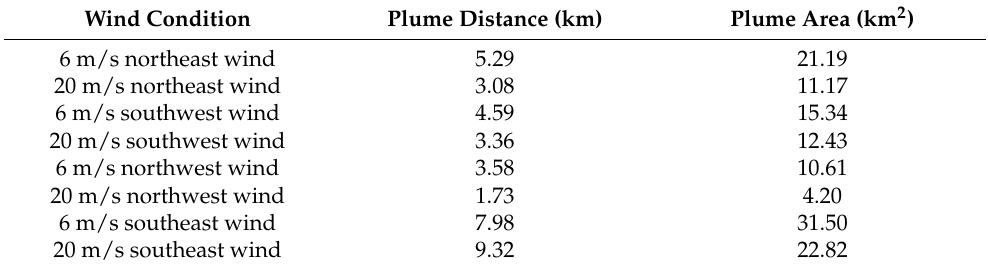
Table 8. Plume distances and plume areas for different wind speeds and